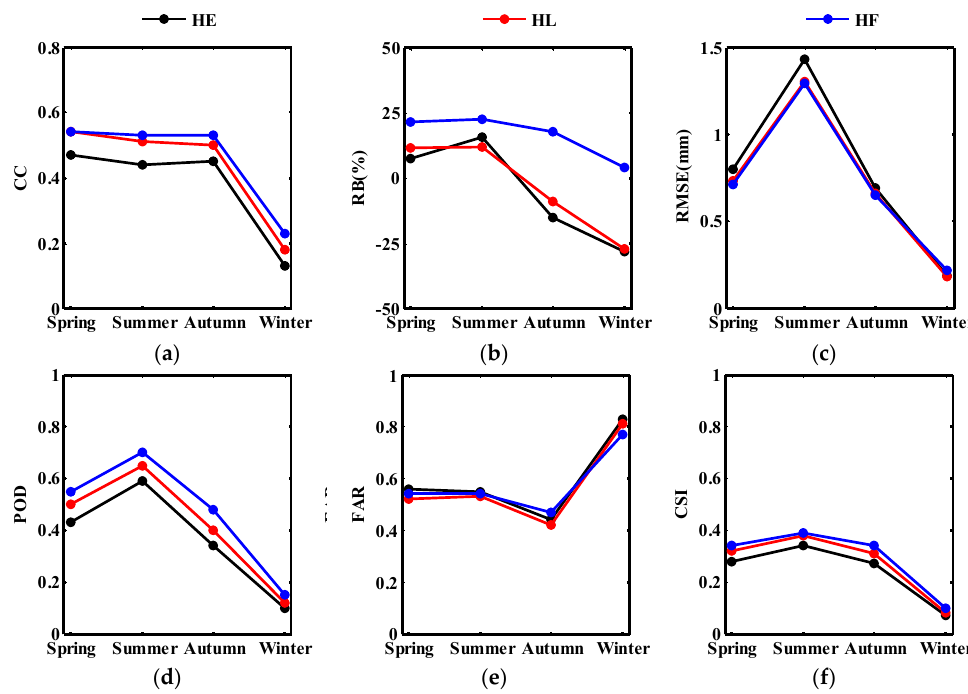
Figure 4. The statistical metrics of seasonal precipitation from the IMERG-HE, IMERG-HL, and IMERG-HF products: ( a ) CC, ( b ) RB, ( c ) RMSE, ( d ) POD, ( e ) FAR, and ( f ) CSI.